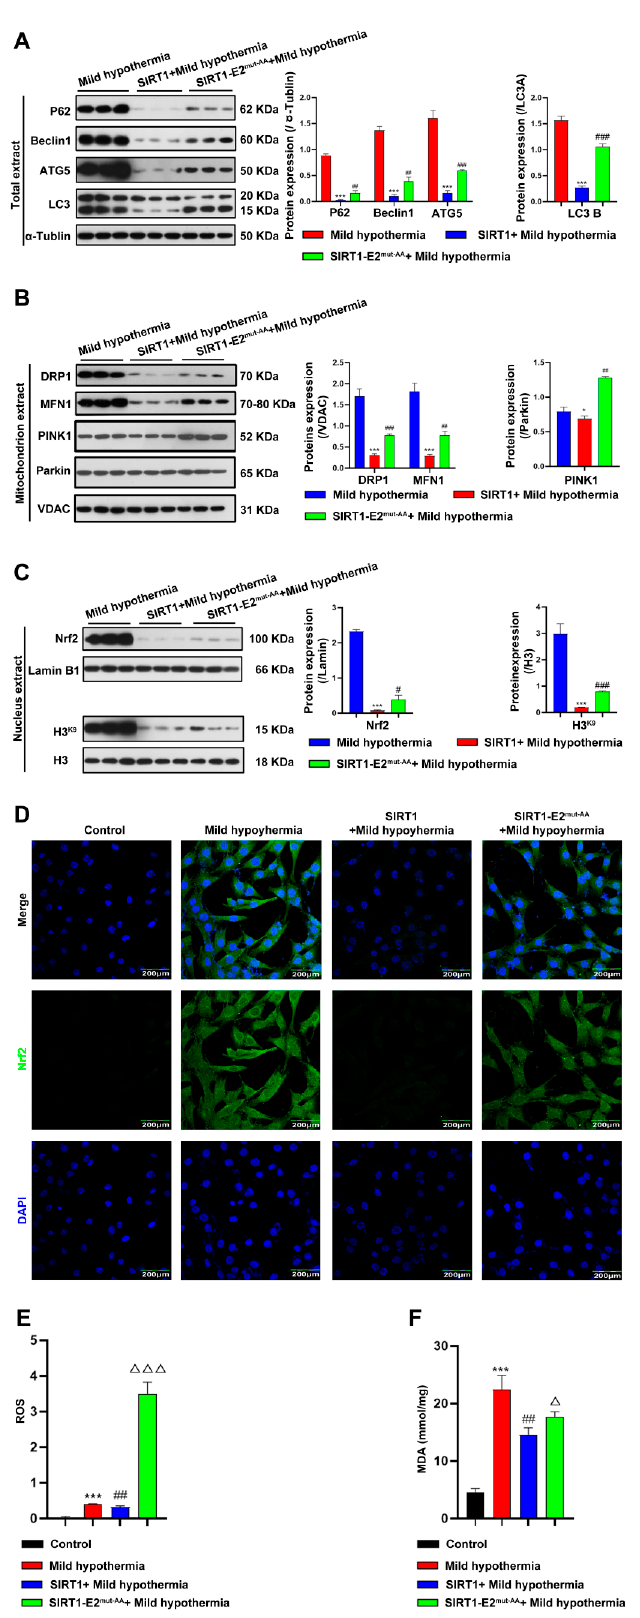
Figure 7. Overexpression of SIRT1 ameliorated CS-induced damage to the mitochondria. After treatment, C2C12 cells were collected and total extract, mitochondrial extract, and nuclear extract were